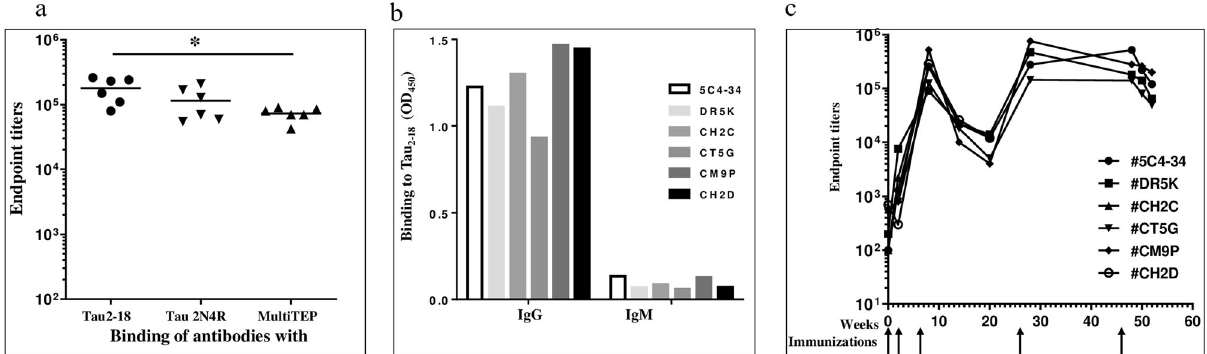
Fig. 5 AV-1980R/A induced high titers of anti-Tau antibodies in Macaca fascicularis. a Endpoint titers of the generated antibodies were evaluated in the sera of individual animals after three immunizations. Horizontal lines indicate the median titer and the x-axis grouping indicates the target-speci fi cities of the generated responses. Titers of generated antibodies speci fi c to MultiTEP are signi fi cantly lower than titers of antibodies speci fi c to Tau2-18 (* p = 0.0173, Ordinary One-way Anova) ( b ) AV-1980R/A induced IgG isotypes of antibodies. Isotypes were analyzed in sera of individual animals diluted 1:2000 after the third immunization. c Dynamics of humoral immune responses in individual animals ( n = 6 at the start, #CH2C was euthanized on week 12, and #CH2D was euthanized on week 24) immunized with AV-1980R/ A on weeks 0, 2, 6, 26, and 46.